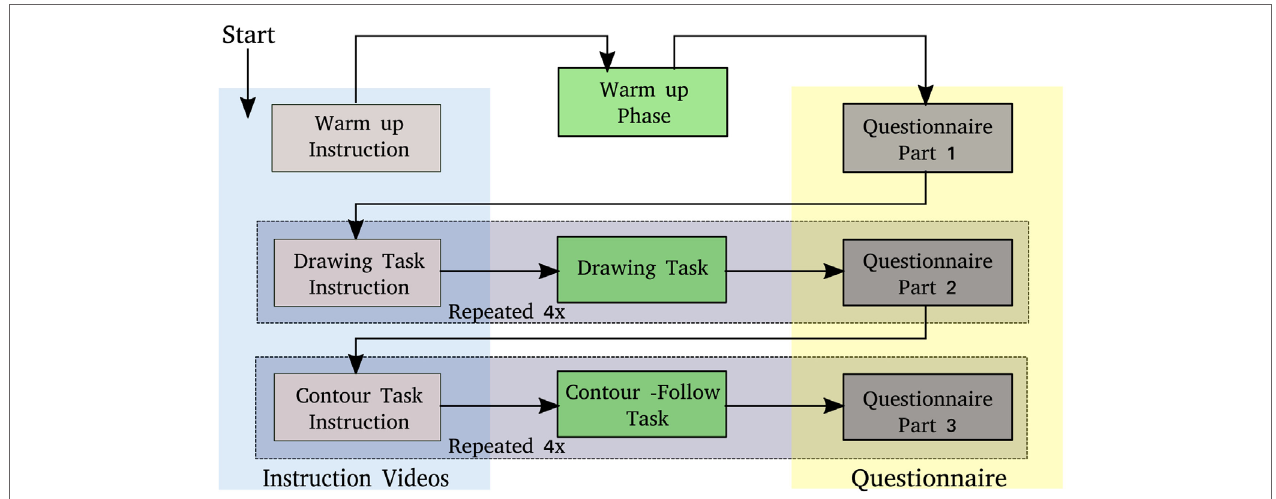
FigUre 3 | The experiment flow, users have to finish the listed tasks to successfully complete the study, the drawing task and contour­following task are repeated four times with different control